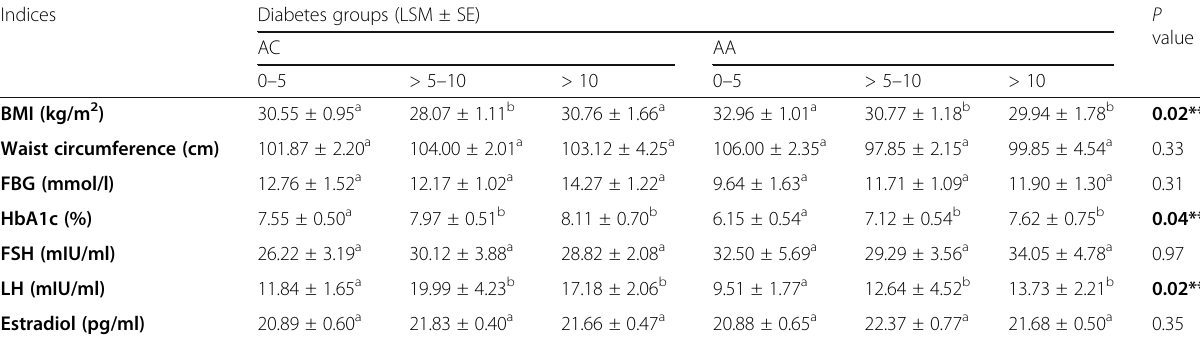
Table 9 Effect of BMP15 genotypes on some physiological parameters of Type 2 diabetic patients among duration of disease Indices Diabetes groups (LSM ±